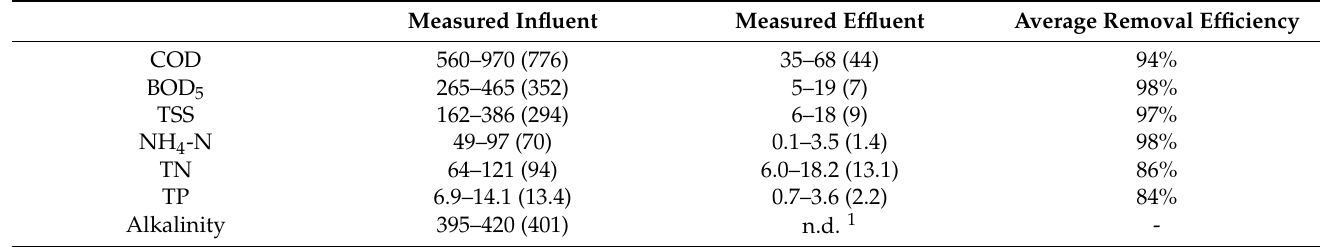
Table 2. Measured raw influent and treated effluent data in mg/L. The averages are in brackets and the treatment efficiency is shown as a percentage.